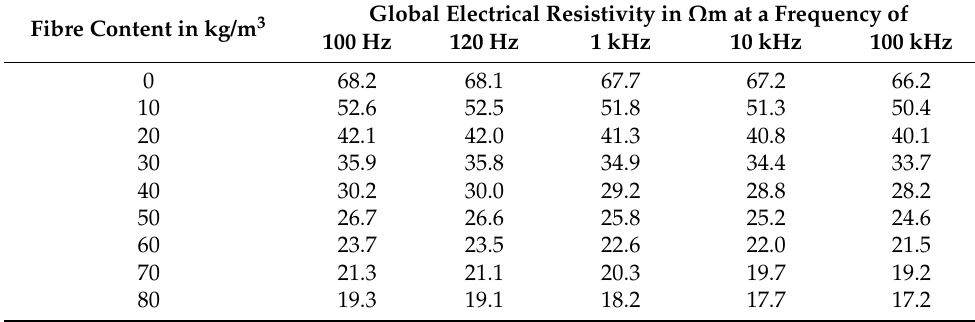
Table A30. Results of the resistivity measurements of the concrete mixture 42-60-270-65.